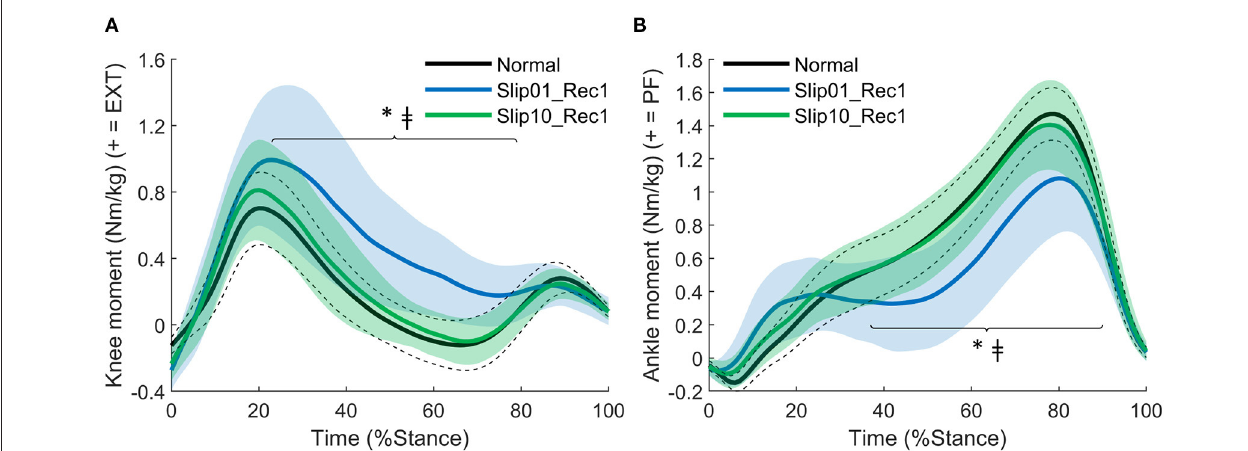
FIGURE 8 | (A) Knee moment: effect of condition between Normal, Slip01_Rec1, and Slip10_Rec1. *: significant difference between Normal and Slip01 (23–79% stance p = 0.002); ‡: significant difference between Slip01 and Slip10 (32–80% stance, p = 0.002). (B) Ankle moment: effect of condition between Normal, Slip01_Rec1 and Slip10_Rec1. *, significant difference between Normal and Slip01 (37–90% stance, p = 0.002); ‡: significant difference between Slip01 and Slip10 (34–89% stance, p < 0.001). Normal: average: solid black line; SD: dotted black lines; Slip01_Rec1: average: solid blue line; SD: blue shaded area; Slip10_Rec1: average: solid green line; SD: green shaded area. See Supplementary Figure 7 for YA and OA curves.